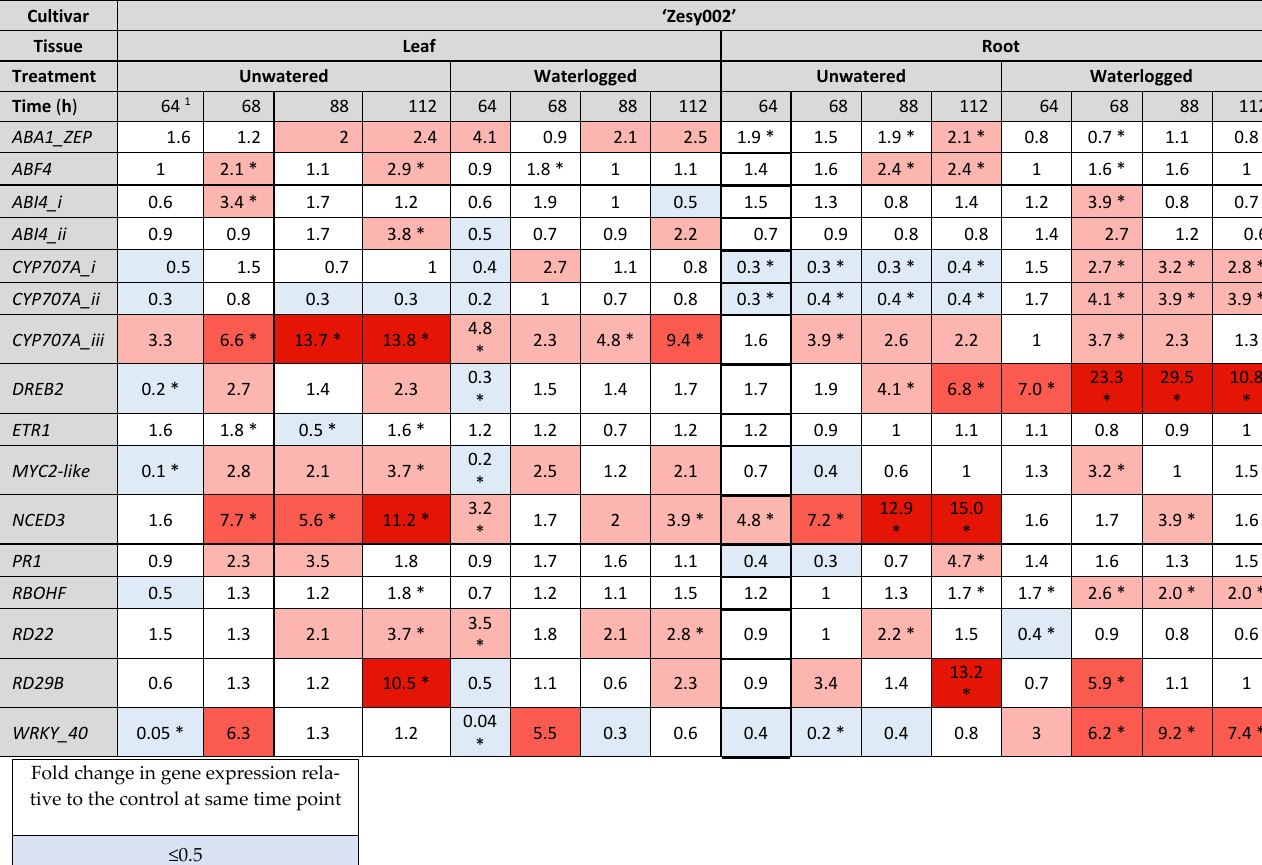
Figure 4. Fold-change in gene expression induced by water stress conditions in leaf and root tissue of Actinidia chinensis var. chinensis ‘Zesy002’ kiwifruit plants after 64 h, 68 h, 88 h and 112 h of water stress treatments in 2020. From time 0 h, plants in the unwatered treatment were not watered and waterlogged plants were subjected to constant water at quarter pot height. Plants in the control treatment received the standard watering regime of 12 min, twice daily. There were five replicate plants/time/treatment. Gene expression was quantified by PlexSet ® NanoString using Actin2 , Glyceraldehyde 3-phosphate dehydrogenase ( GAPDH ) and Protein phosphatase 2A ( PP2A ) as the reference genes. The genes of interest are shown in the left-most column. Statistical analysis was performed at the log₂ scale, and the heat map shows fold change data between water stressed plants and the control at the same time point. Fold-change data in red shades (defined in the color panel) indicate an up-regulation relative to the control, whilst blue shades represent down-regulation relative to the control. Fold changes of 0.5 – 2 are often considered to be statistically unreliable [25 – 27]. Statistically significant differences from the control at individual time points, as determined by ANOVA at ( p ≤ 0.05 ) are identified with an asterisk.